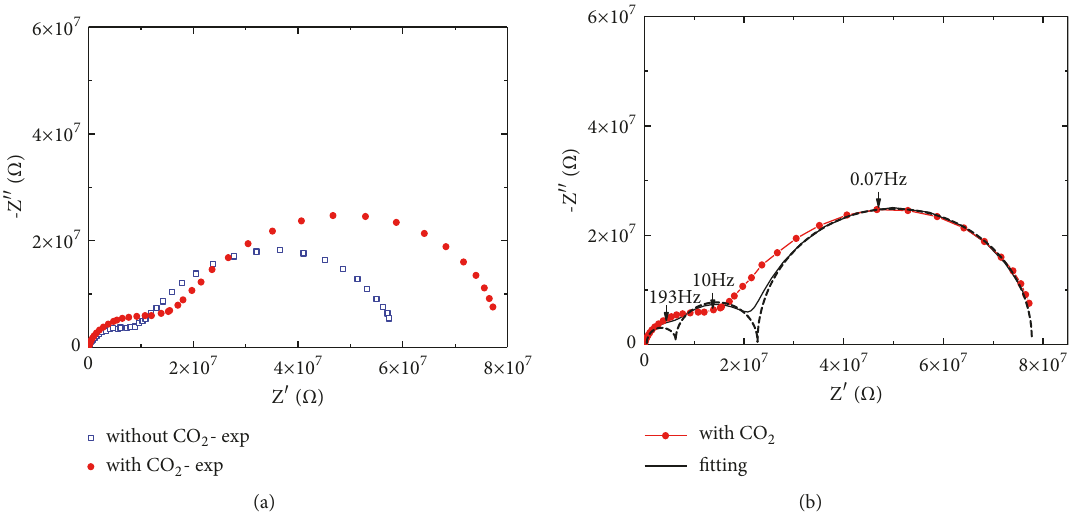
Figure 9: (a) Impedance of Z5A-2 at 373 K with/without CO 2 ; (b) curve fitting by an equivalent circuit.